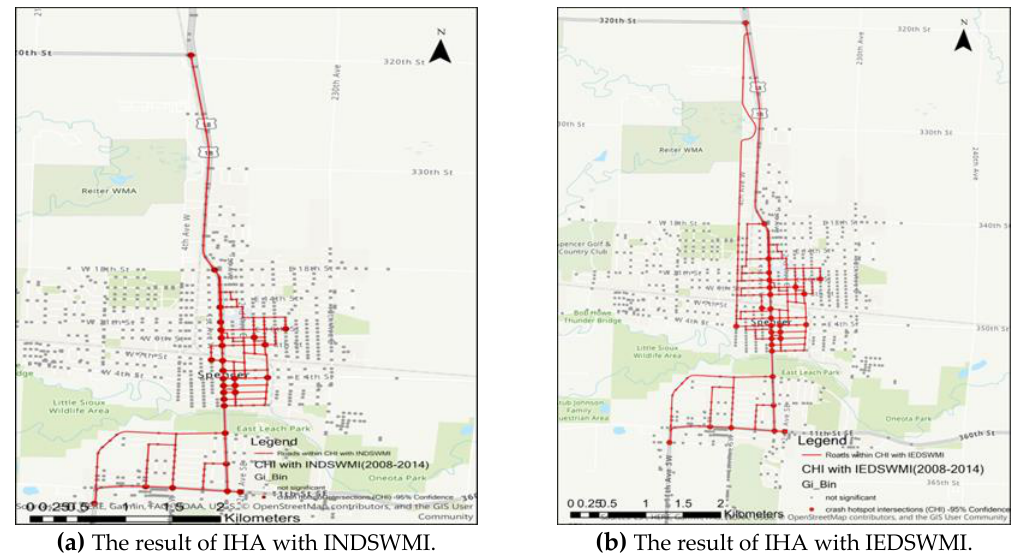
Figure 12. Visual comparison of IHA using the INDSWMI and IEDSWMI.